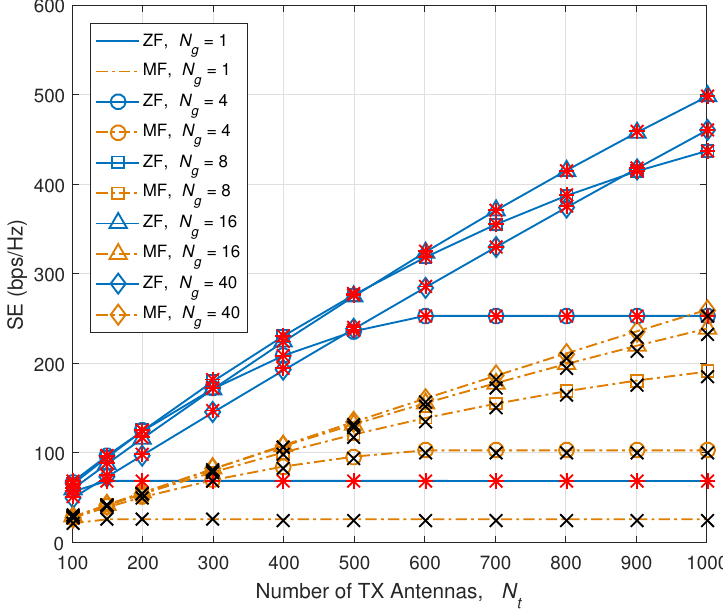
Figure 6. SE versus number of TX antennas, N t . Red ‘*’s and black ‘x’ indicate the simulation